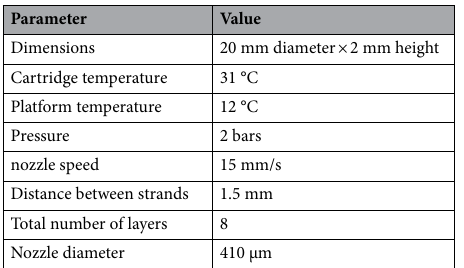
Table 2. Applied parameters to 3D print the cartilage portion of the